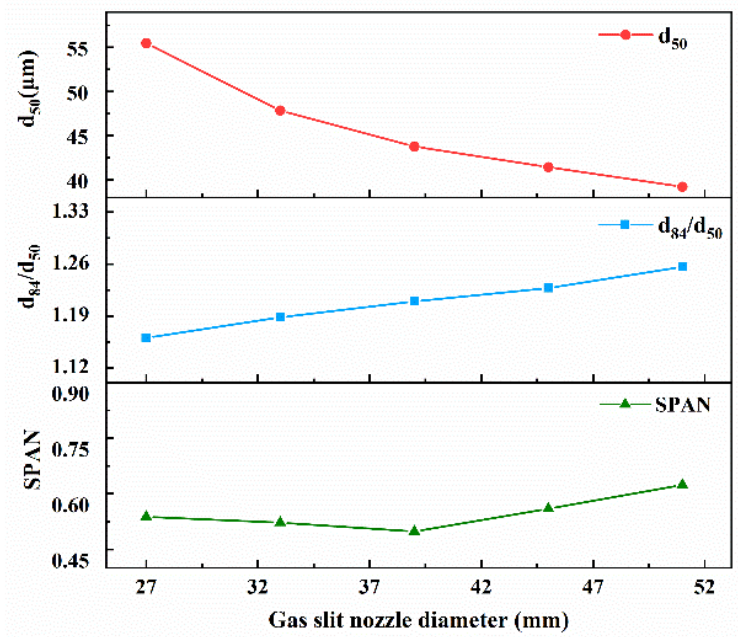
Figure 19. The e ff ect of gas slit nozzle diameter on d 50 , d 84 / d 50 and SPAN for the KHRT breakup Figure 19. The effect of gas slit nozzle diameter on d 50 , d 84 /d 50 and SPAN for the KHRT breakup model model simulation.